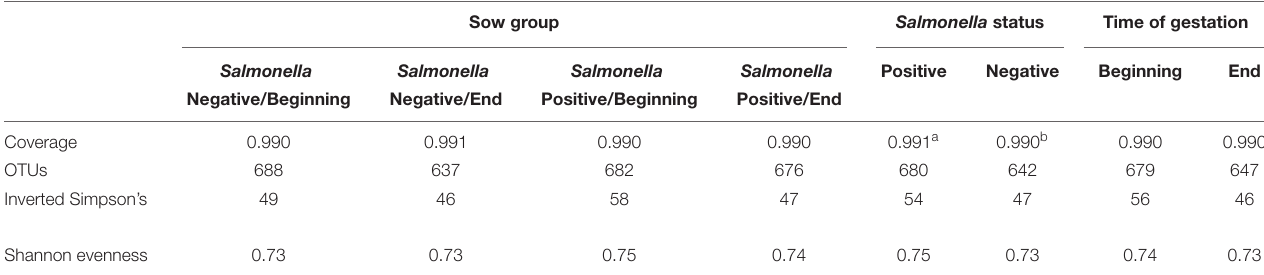
Frontiers in Microbiology |